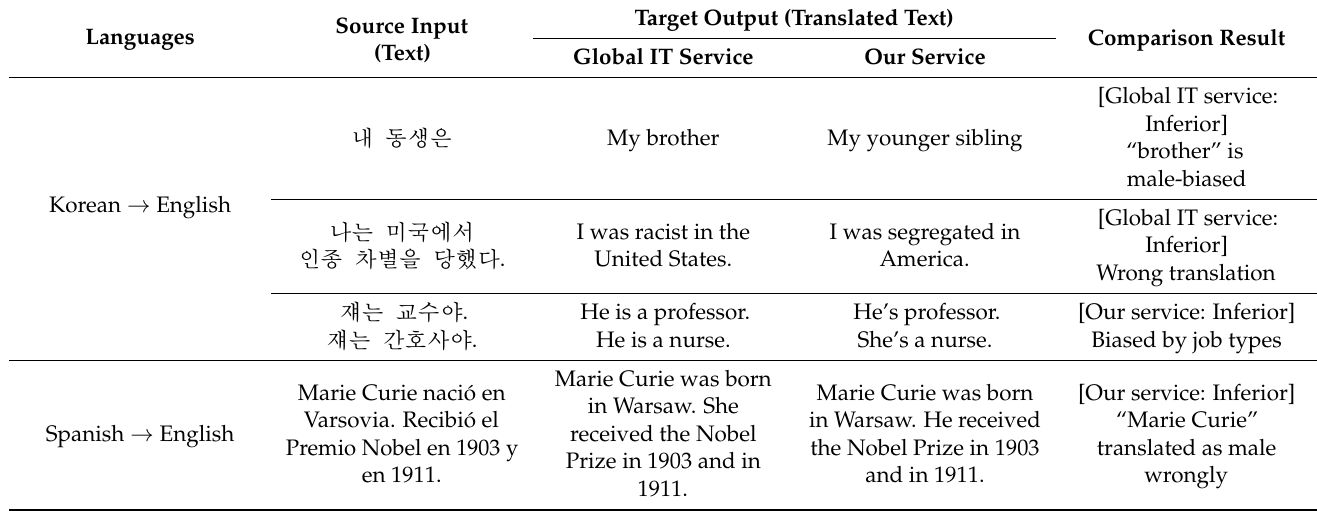
Table 14. Comparison of fairness issues in two language translation